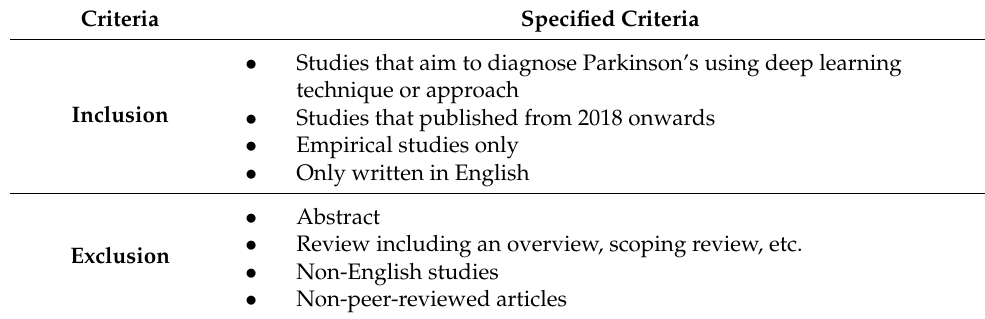
Table 1. Inclusion and exclusion